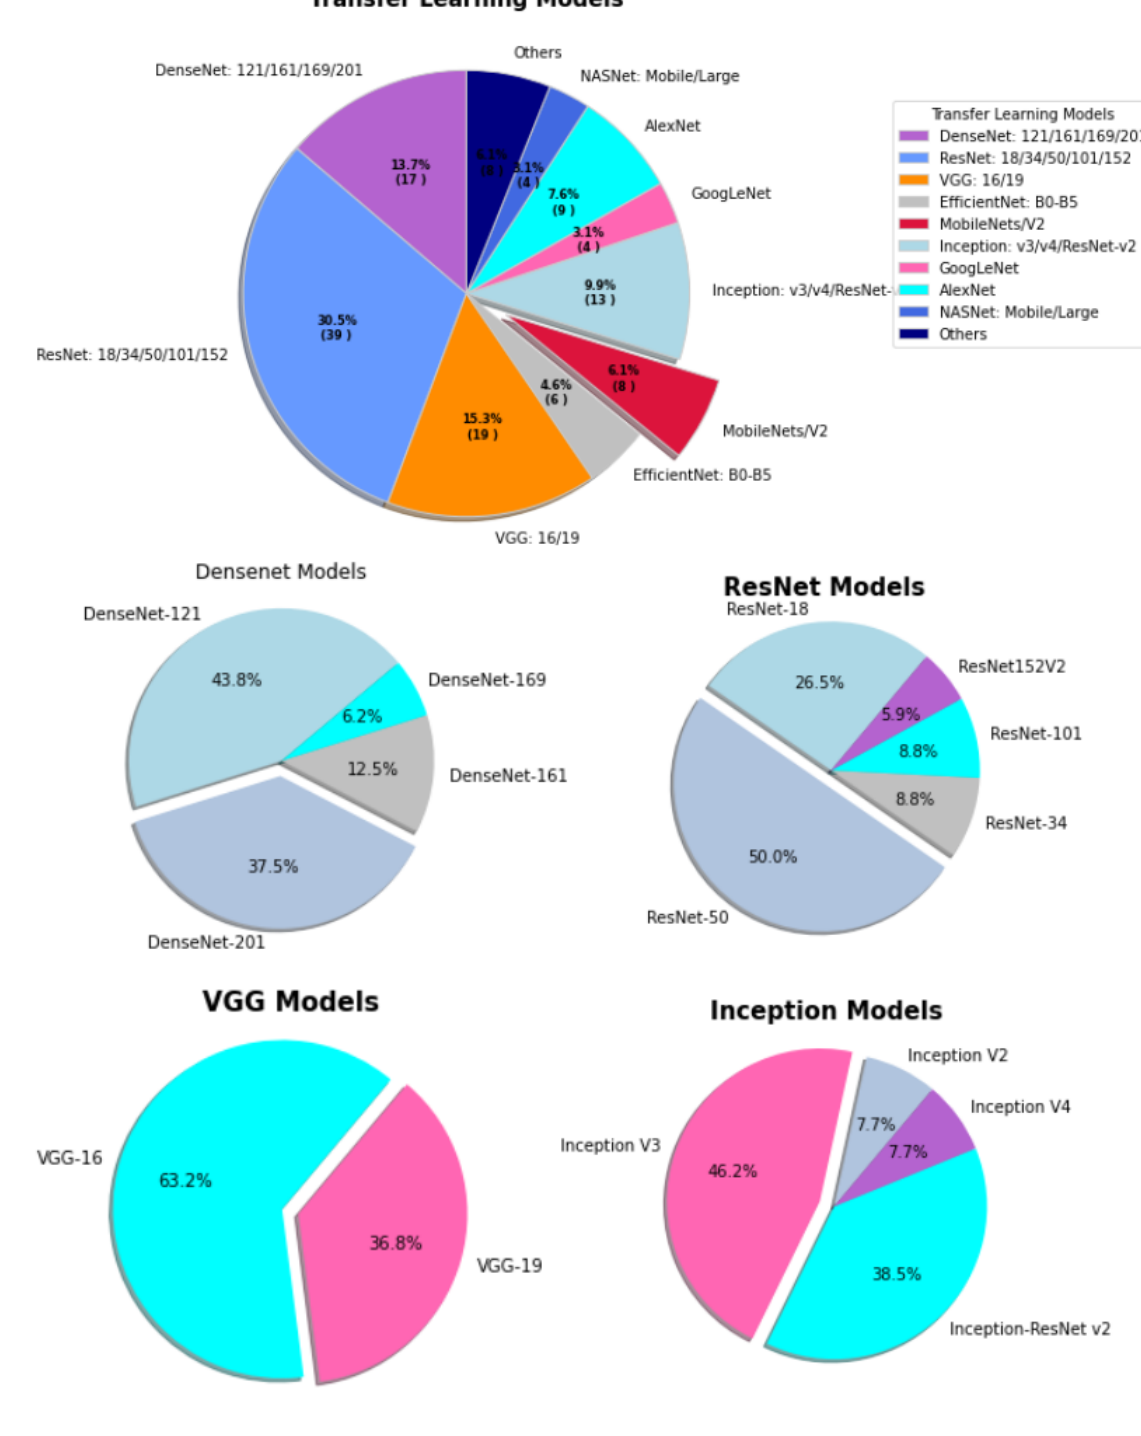
Figure 6. The percentages of various transfer learning models used for